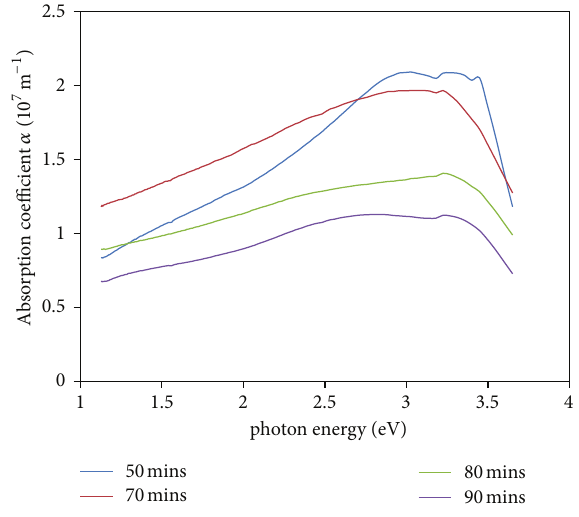
Figure 10: Absorption coefficient versus photon energy.